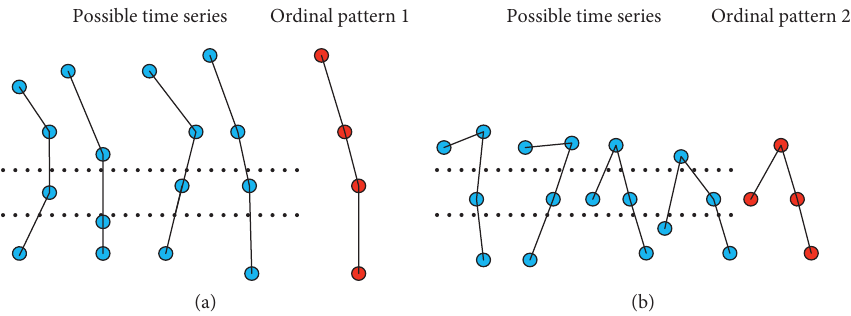
Figure 2: Two examples of diverse time series with the same sort